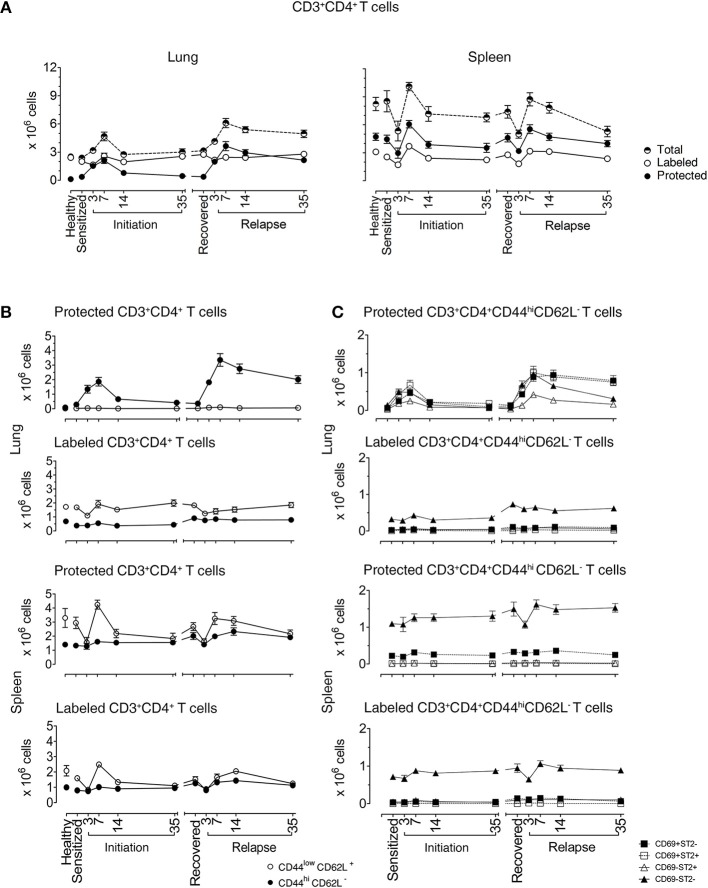
Lung CD3+CD4+ T cells are protected from in vivo antibody labeling during allergic asthma in mice. (A) Healthy mice and mice over the course of allergic asthma were in vivo labeled with anti-CD4 mAb (clone RM4-4) and organs were extracted 10–15 min later. Lung and spleen cell suspensions were prepared and stained with a non-overlapping anti-CD4 mAb (clone RM4-5) and antibodies for other extracellular markers for flow cytometric analysis. Number of total, protected and labeled CD3+CD4+ T cells in the lungs and spleens are shown during initiation, after 185 days of recovery (range from 142 to 234 days) and during relapse. (B) Number of protected and labeled effector/memory and naïve Th cells in lungs and spleens of healthy animals and mice in various stages of allergic asthma. (C) Number of protected and labeled CD3+CD4+CD44hiCD62L− T cells with differing ST2 and CD69 expression in spleen and lung of healthy controls, during asthma initiation, after 185 days of recovery (range from D142–234) and relapse. Data are shown as mean ± SEM of 8–16 mice/time point and were compiled from 6 independent experiments.